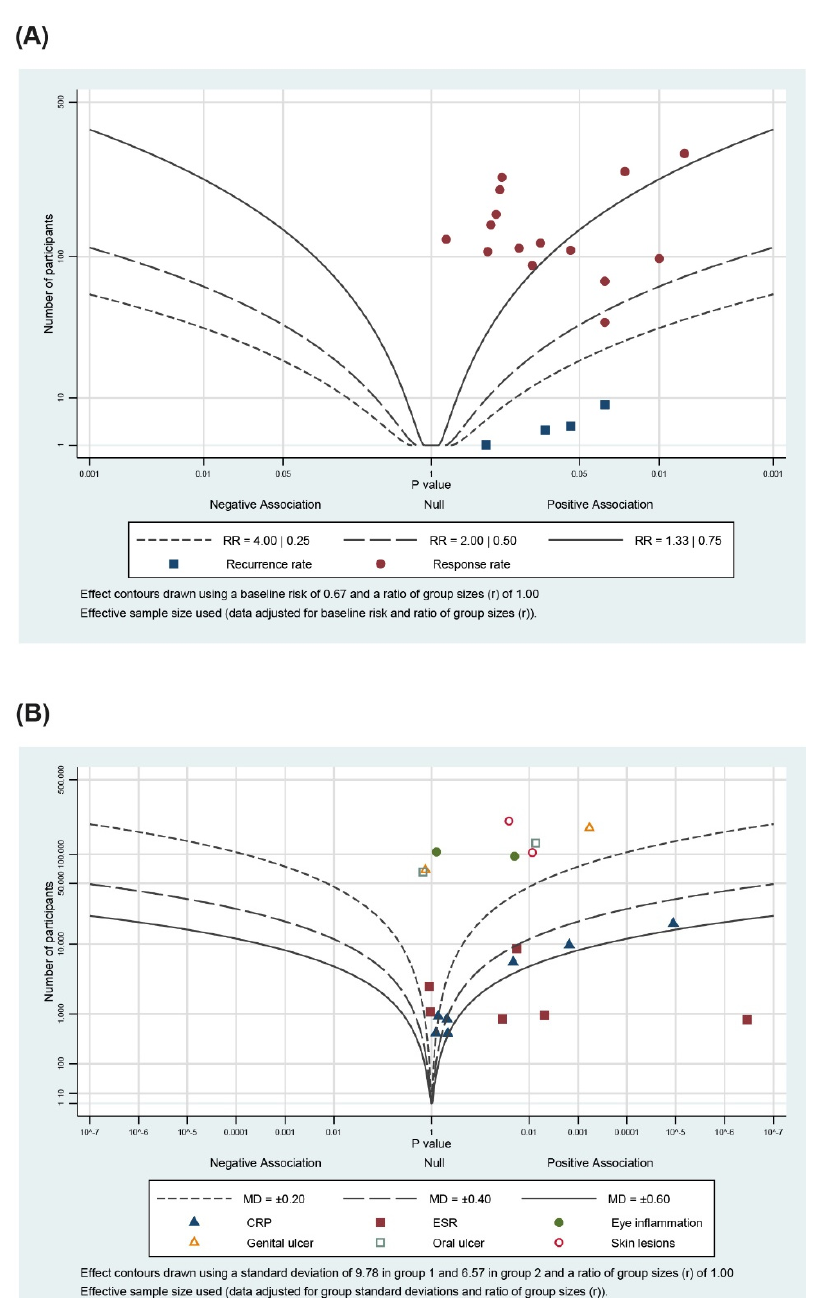
Figure 5. Albatross plot for ( A ) primary outcomes and ( B ) secondary outcomes.